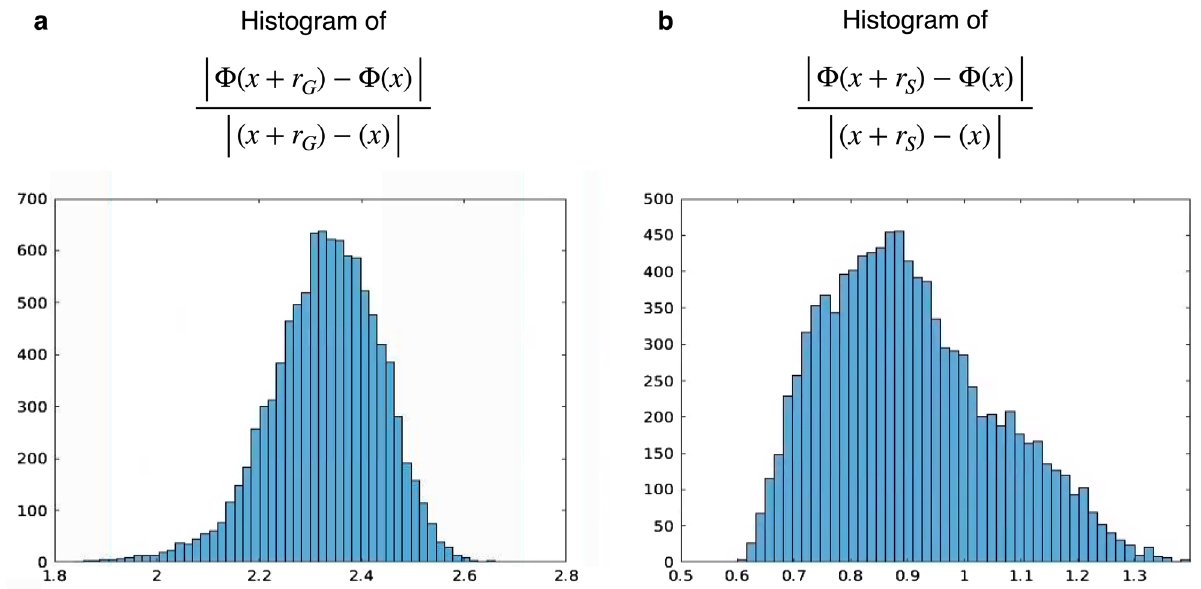
Figure 5. AUTOMAP is locally stable to noise: ( a ) histogram of the output-to-input variation ratio taken over noiseless- and Gaussian noise applied input data, with a low maximum value of 2.7. ( b ) histogram of the same output-to-input variation ratio taken over noiseless and Gaussian plus spike noise applied to the input data, with low maximum value of